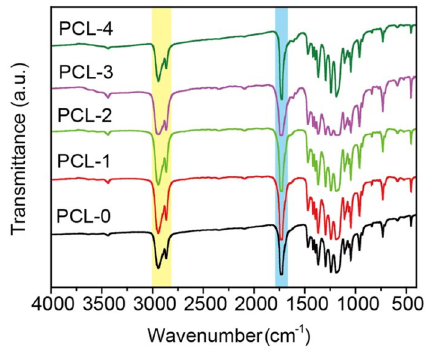
Figure 4. FT-IR spectra of PCL-based nanofibrous membranes.